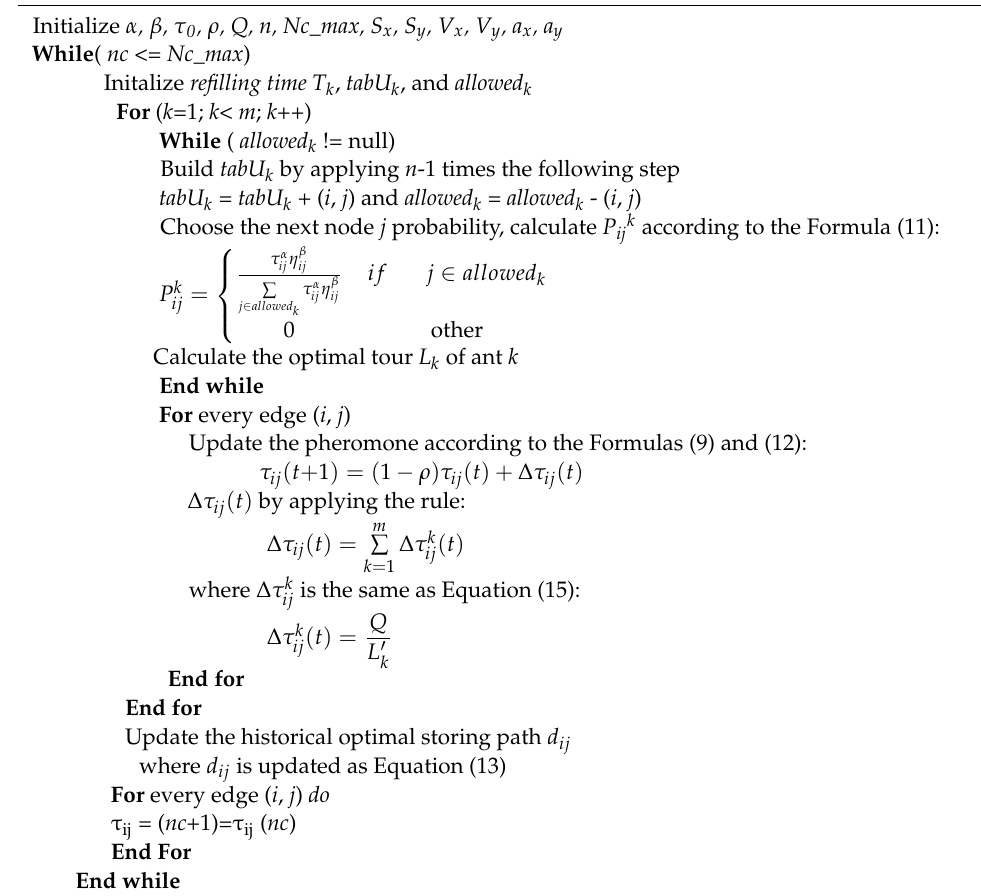
Algorithm 1. (improved ant colony algorithm sequence (iacs)